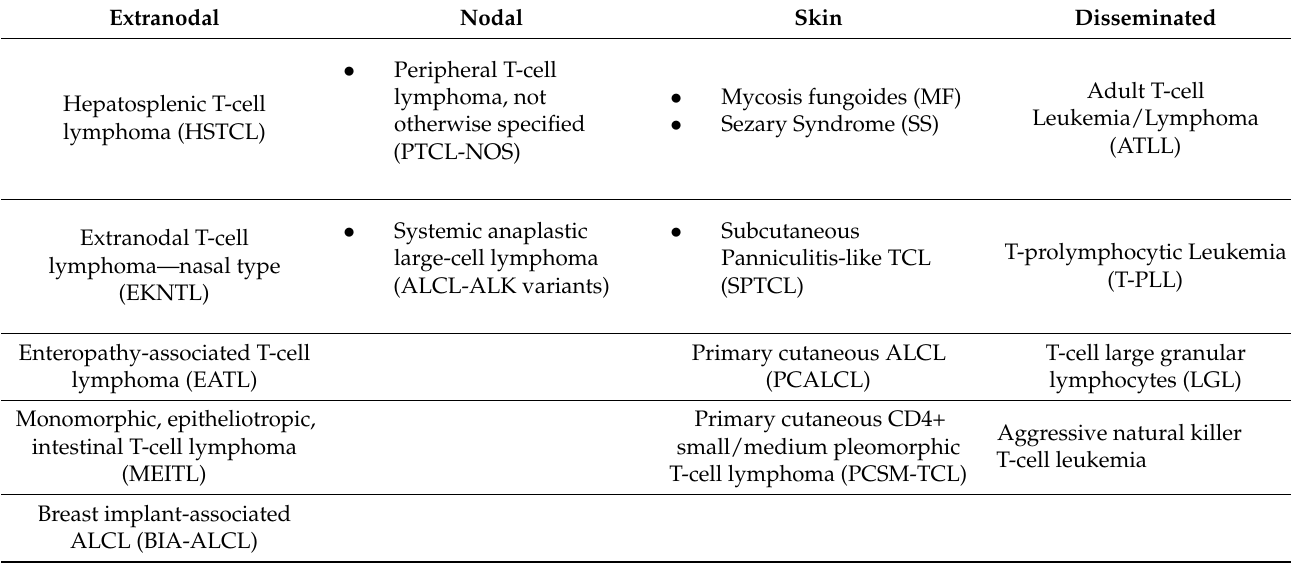
Table 3. Suggested clinical classification of mature T-cell lymphomas based on initial site of presentation.